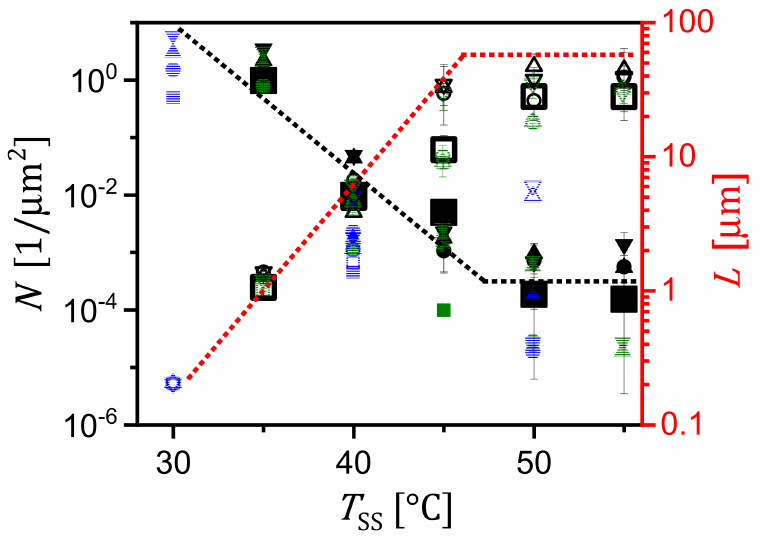
Figure 5. The effect of self-seeding temperature ( T SS ) on the size (mean value of the side length L , open symbols) of the crystals and their number density ( N , closed symbols), shown for various con- centrations ( c ), crystallized at T C = 13 ◦ C (black), 20 ◦ C (green) and 22 ◦ C (blue) for 24 h, respectively. Squares, circles, up triangles and down triangles represent data points obtained for c = 5 mg/mL, c = 10 mg/mL, c = 20 mg/mL and c = 40 mg/mL,